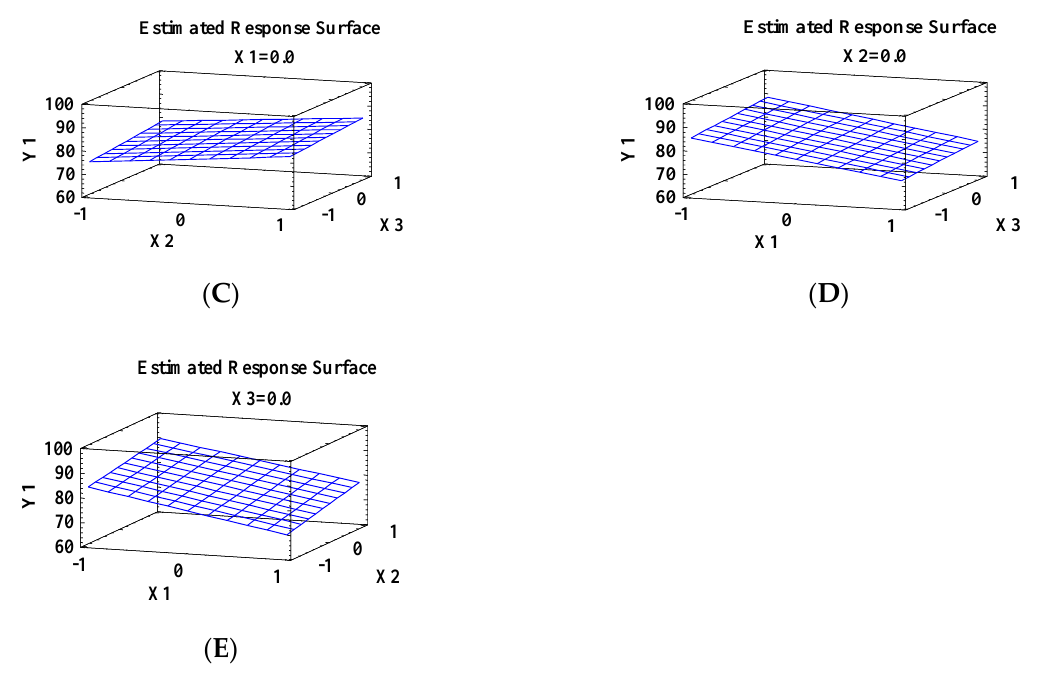
Figure 1. The effect of independent variables on the EE% (Y1) including the Pareto chart ( A ), main plot effect ( B ), and three-dimensional contour plots ( C – E